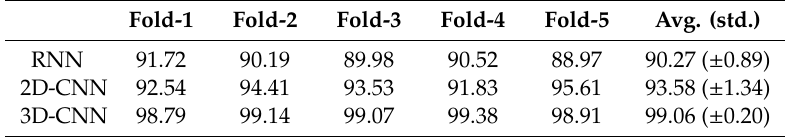
Table 1. Accuracy (%) comparison per fold and the average of the proposed hand gesture recognition system with other machine learning-based systems using the source domain